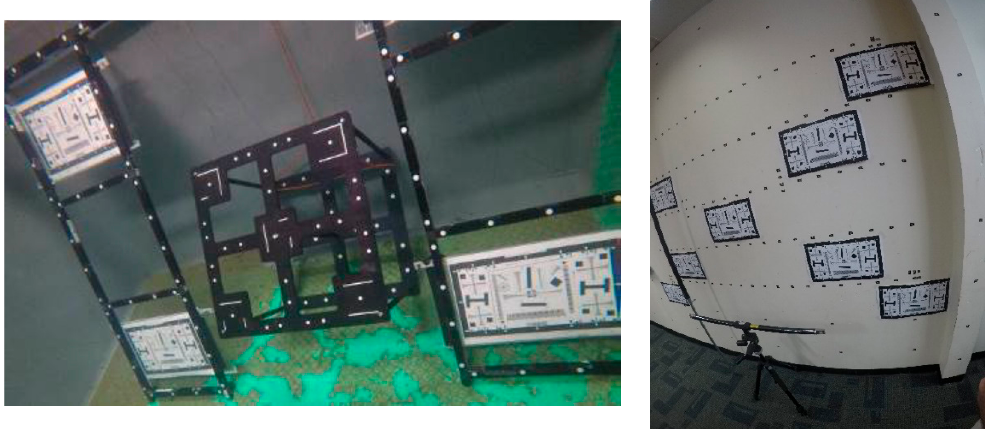
Figure 3. Calibration setup: underwater ( left ) and in-air ( right ).